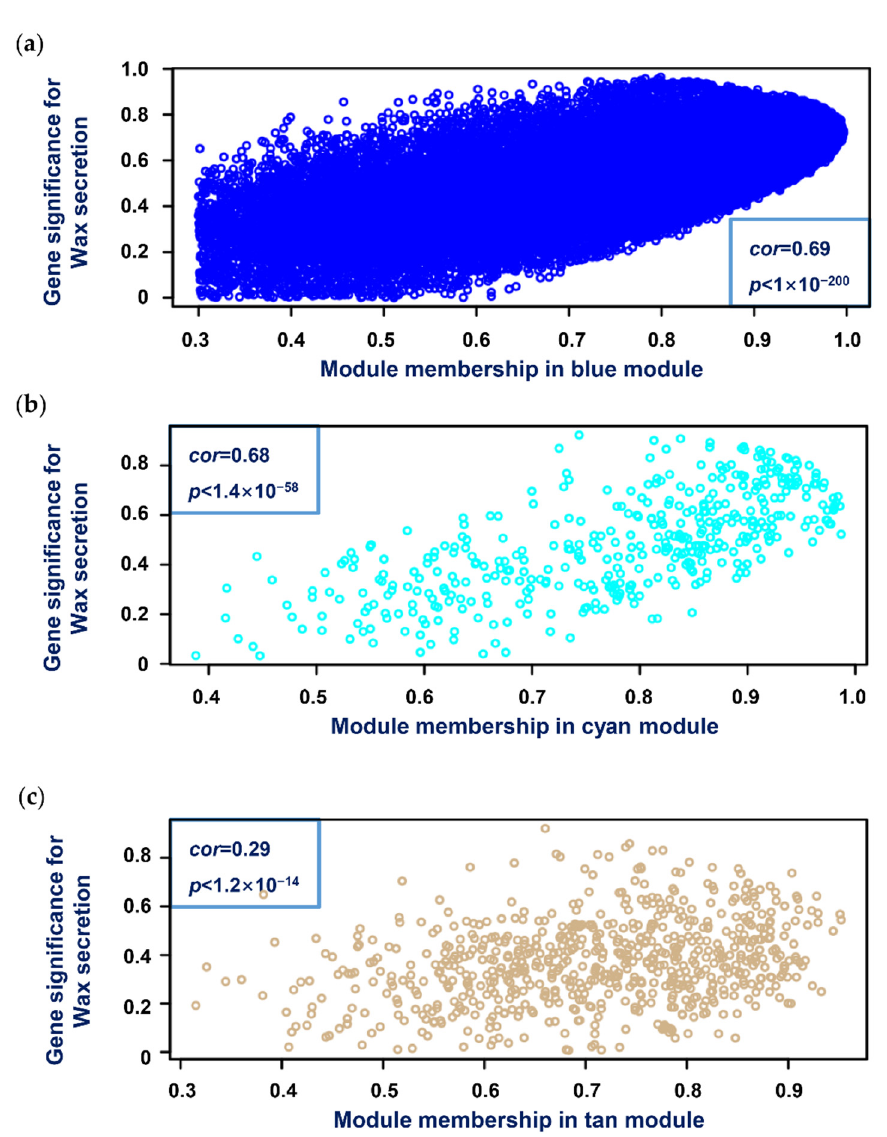
Figure 3. Scatterplots of gene significance (GS) vs. module membership (MM) in the blue ( a ), cyan ( b ), and tan ( c ) modules. There was a highly significant correlation between GS and MM in these modules.